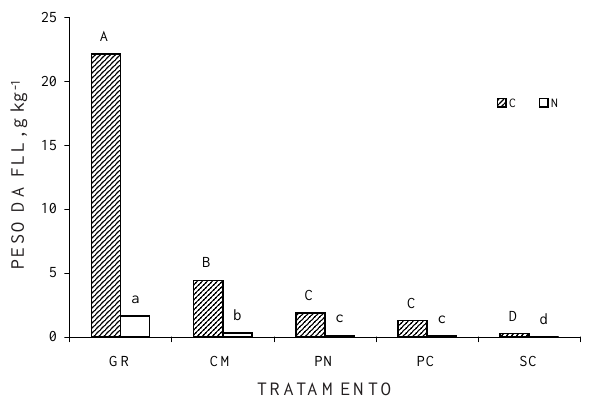
Figura 4. C e N na fração leve livre (FLL) nos diferentes tipo de preparo do solo e cobertura vegetal. Médias seguidas da mesma letra maiúscula, para teor de C total, e seguidas da mesma letra minúscula, para teor de N total, não diferem entre si (Tukey p < 0,05).